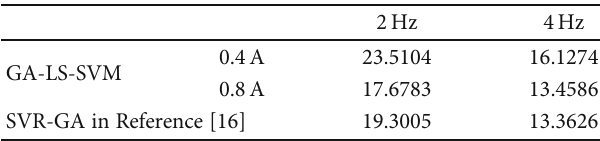
Figure 10: F - v comparison curves of di ff erent current values under excitation of 4Hz and 15mm. Table 1: MSE